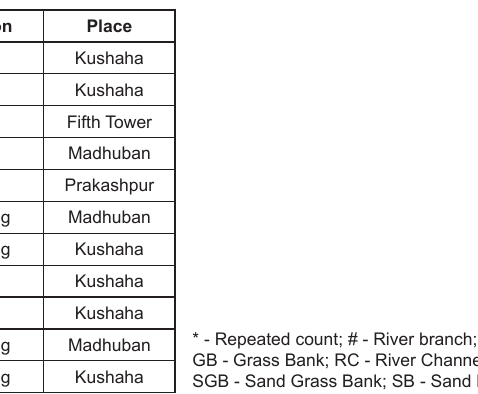
Table 2. The result of survey in spring 2008